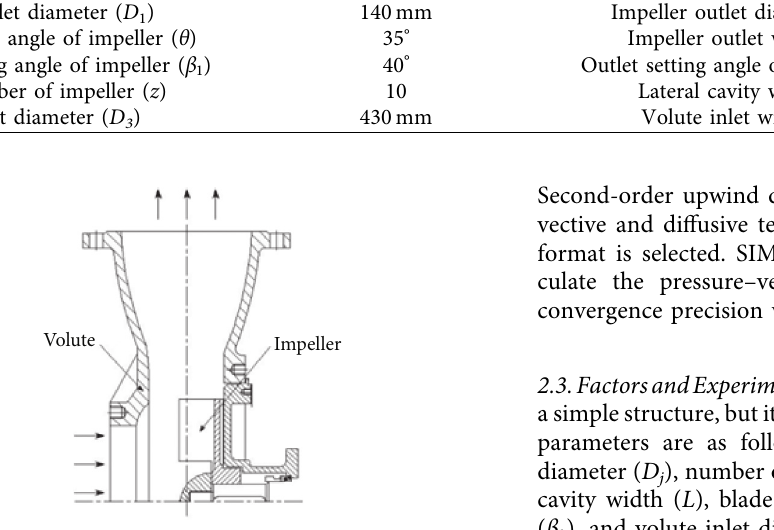
Figure 1: Simple diagram of pump section model.